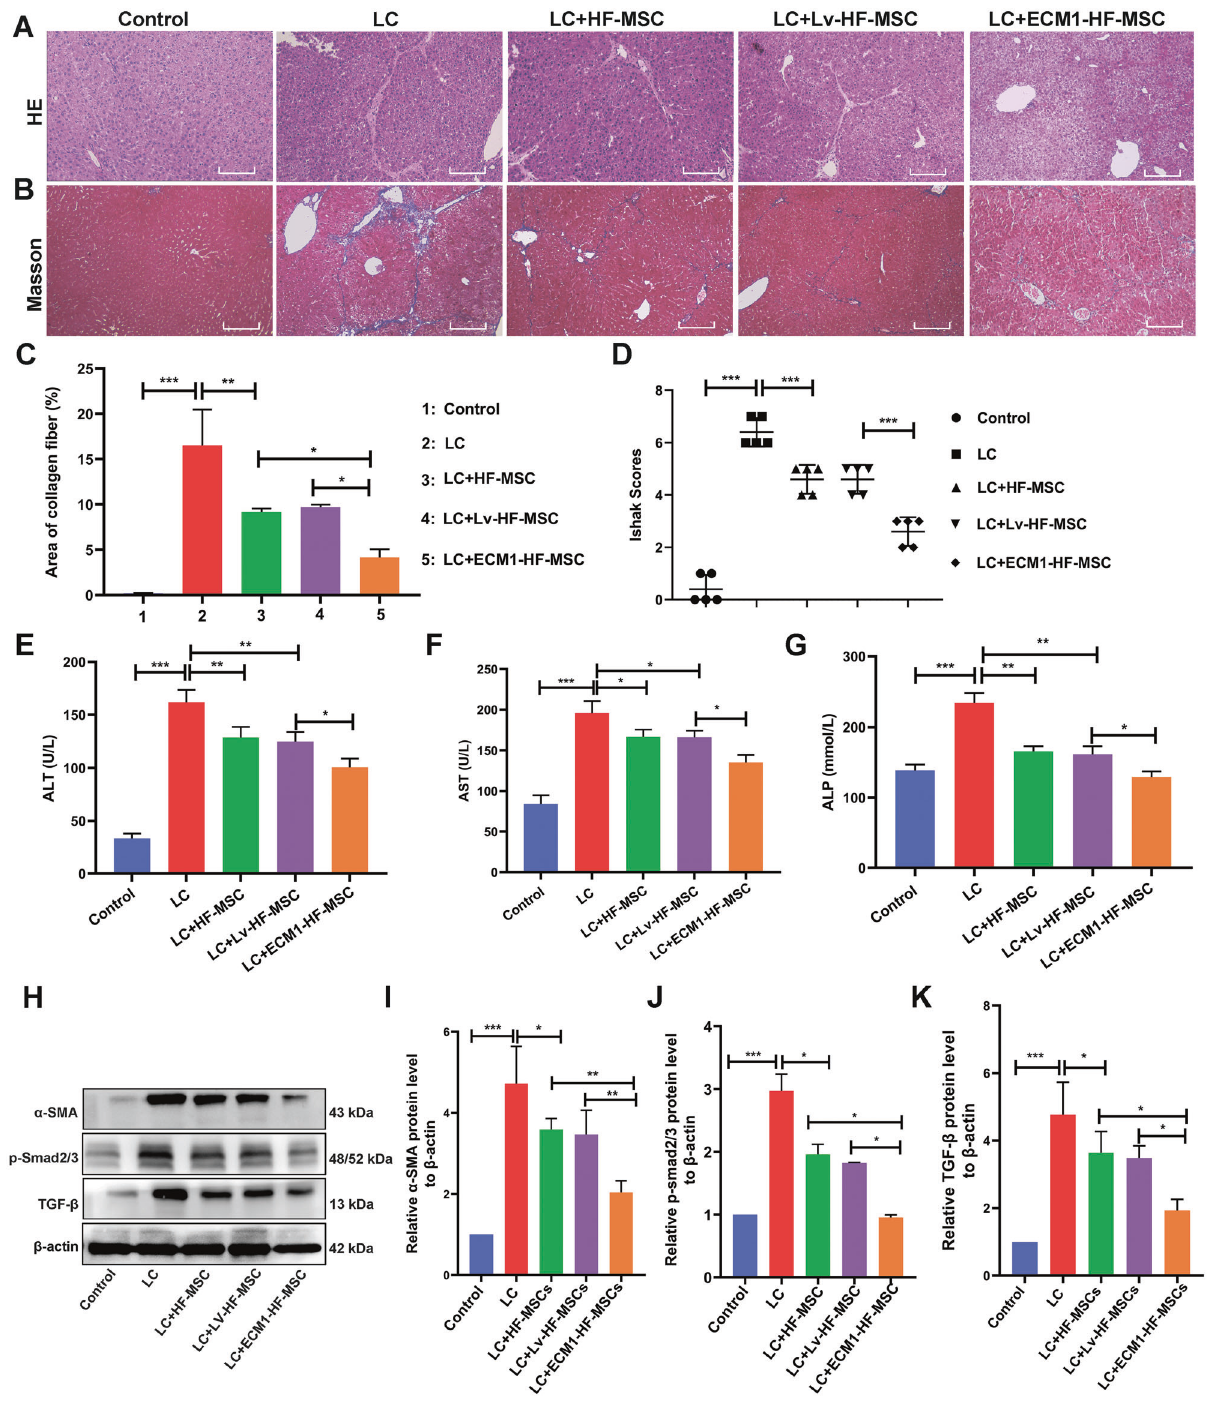
Fig. 7 ECM1-HF-MSCs show a better effect in LC treatment through inhibiting the activation of HSCs and the TGF- β /Smad signaling pathway in vivo. A , B HE and Masson staining in each group. Scale bar = 100 μ m. C Area of collagen fi bers in each group. D Ishak scores show the degree of LC in all groups. E – G Changes in the serological indices of ALT, AST and ALP. H – K Western blotting and semiquantitative analysis of a-SMA, p-Smad2/3, and TGF- β in all groups. Data are shown as the means ± SDs (* p < 0.05, ** p < 0.01, *** p <